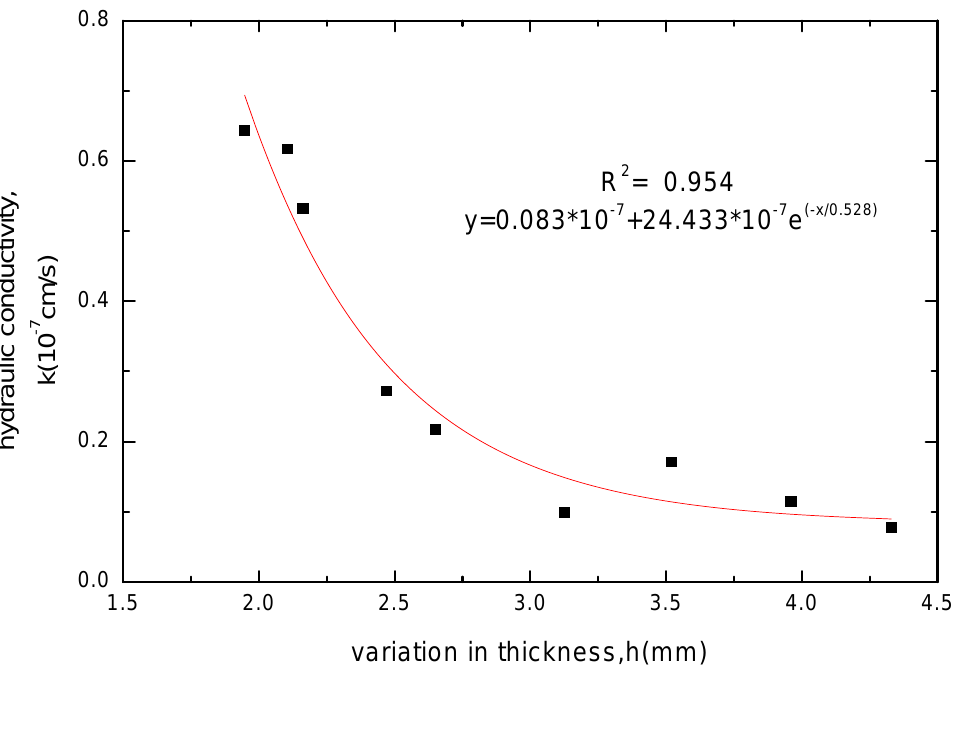
Figure 10. The relationship between hydraulic conductivity and thickness increase for GCL specimens soaked with NaCl